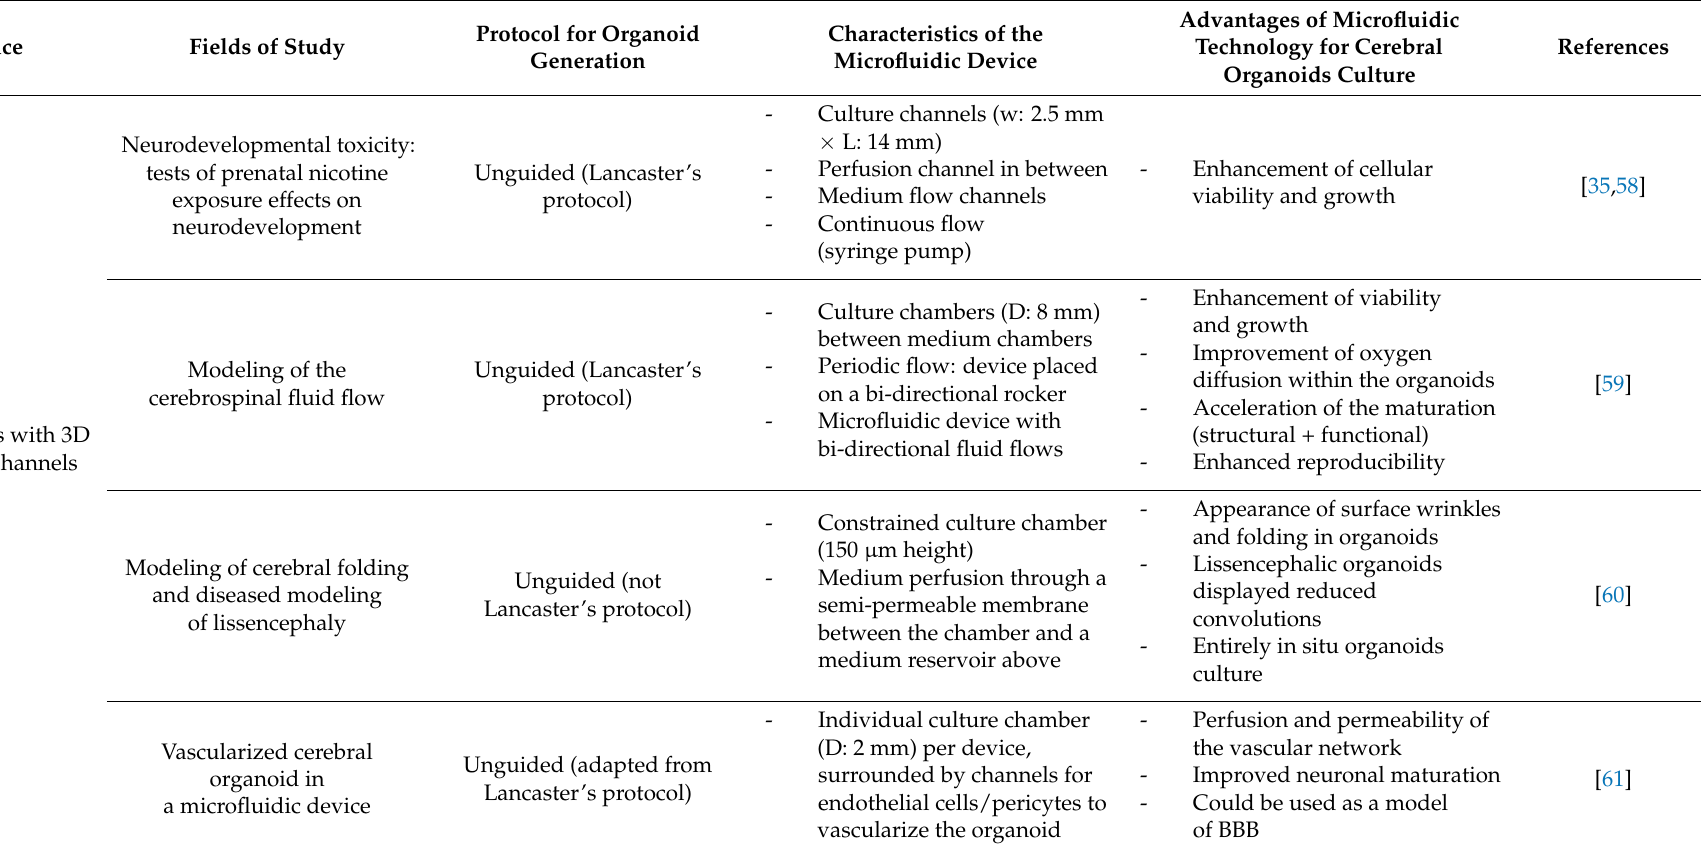
Table 1. State-of-the-art of recent brain organoids-on-chip technologies with their advantages for cerebral organoid cultures (W: width; L: length; D: diameter; H: